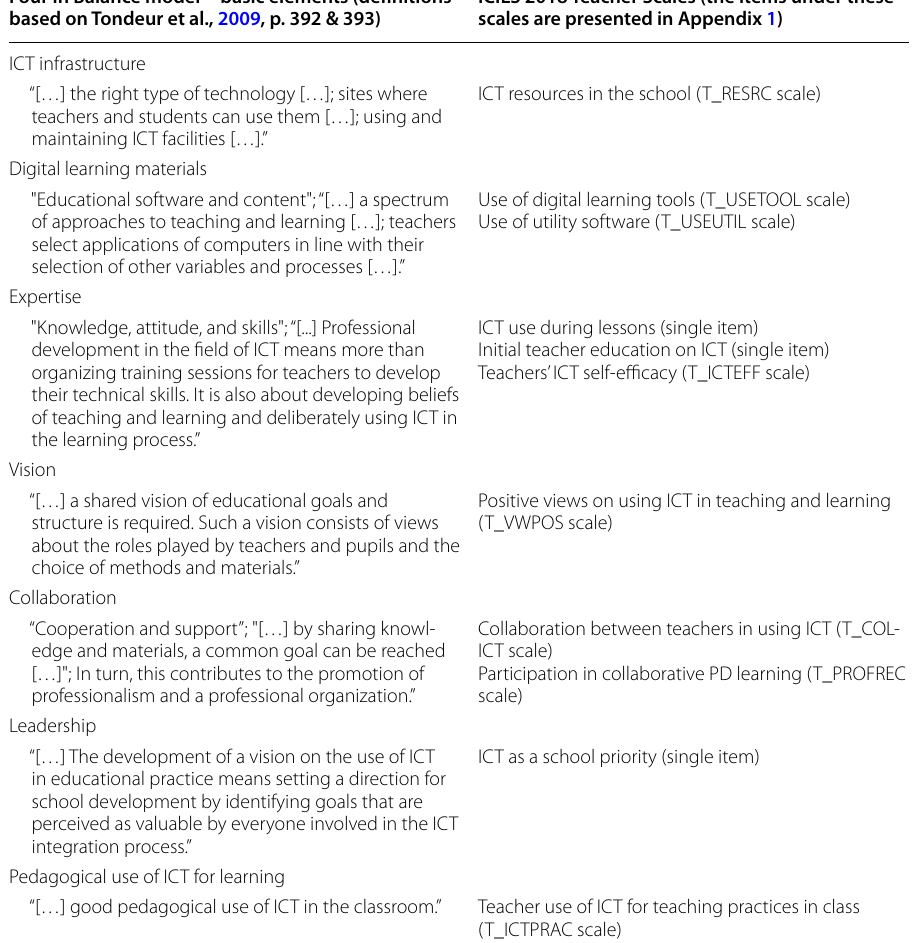
Table 1 The ICILS 2018 Teacher scales and single items selected as proxy measurements for the basic elements of the Four in Balance